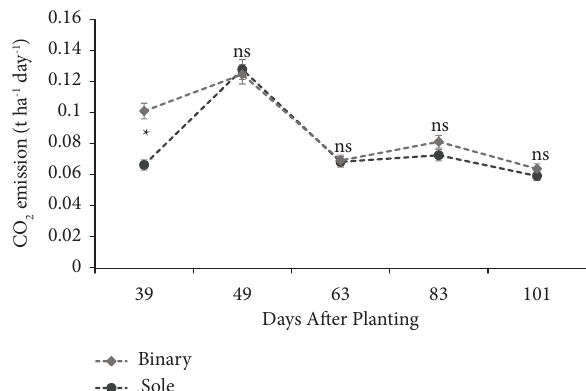
Figure 8: CO 2 emission rates in intercropping (binary) and sole cropping system during the 2020/21 cropping season at Ofcolaco. ns signifcant; ∗ � signifcant at p ≤ 0.05.